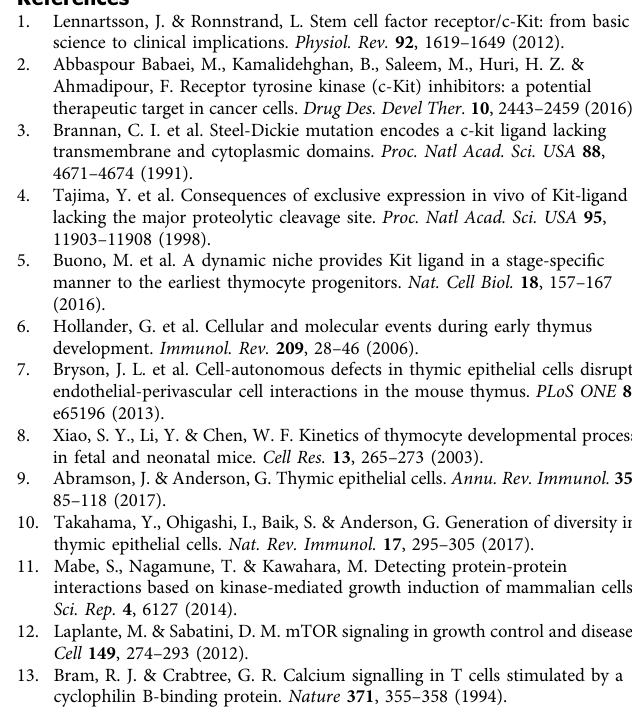
Table 2. Cells were stained on ice for 20min in the dark. Data were acquired using LSR Fortessa X-20 (BD Biosciences) and analysed using FlowJo software (TreeS- tar). Thymocyte and thymic VECs were quanti fi ed by fl ow cytometry using the antibodies described in Supplementary Table 4. Phospho-proteomic analysis . Cells were stimulated with Kit-Fc or IgG-Fc in 3 up-scaled (3×) replicates each as described above. The obtained lysates were reduced with 200 mM TCEP for 1h at 55 °C and alkylated with 375 mM iodoa- cetamide for 30 min at room temperature in the dark. Proteins were precipitated Samples were dried and re-suspended in 200 µl 50 mM TEAB for TMT labeling. Peptide concentrations were quanti fi ed using the Pierce Quantitative